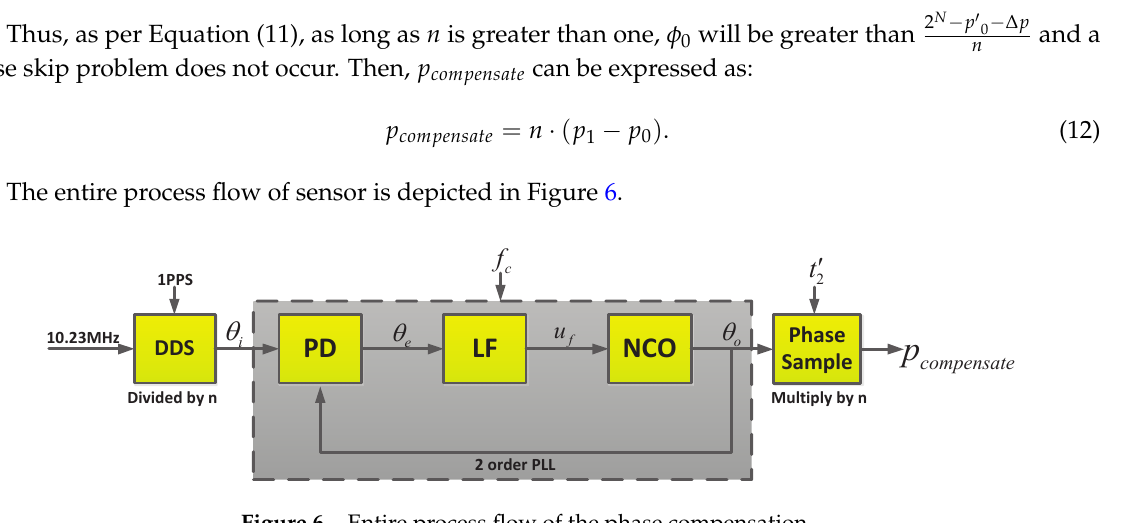
Figure 6. Entire process flow of the phase